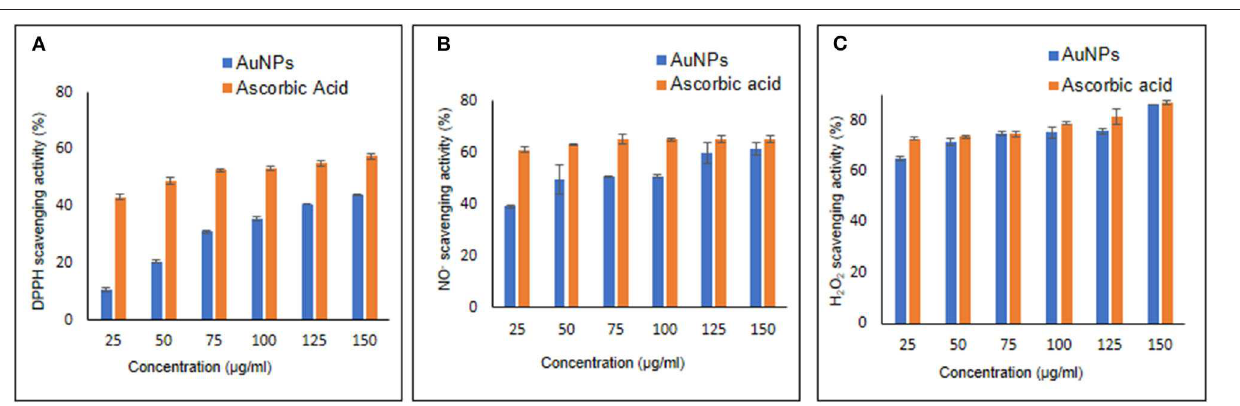
FIGURE 6 | Antioxidant activity estimated by (A) DPPH scavenging activity, (B) NO − scavenging assay, and (C) H 2 O 2 scavenging